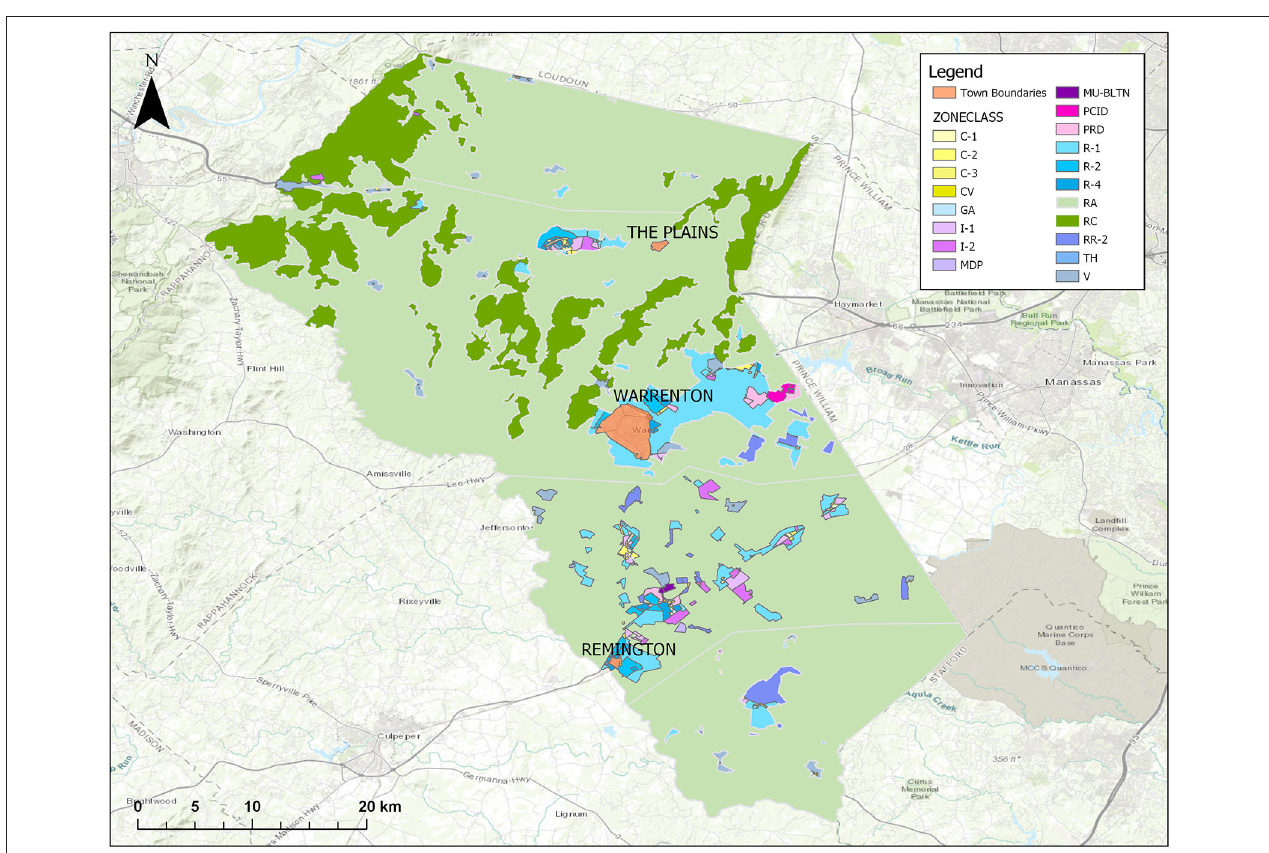
FIGURE 2 | Fauquier County development zones. C1, commercial neighborhood; C2, commercial highway; C3, shopping center; CV, commercial village; GA, garden apartments; I1, industrial park; I2, industrial general; MDP, manufactured dwelling park; MU-BLTN, mixed use Bealeton; PCID, planned commercial industrial development; PRD, planned residential development; R1, residential 1 dwelling unit/acre; R2, residential 2 dwelling unit/acre; R4, residential 4 dwelling unit/acre; RA, rural agriculture; RC, rural conservation; RR2, rural residential; TH, townhouses; V, village.